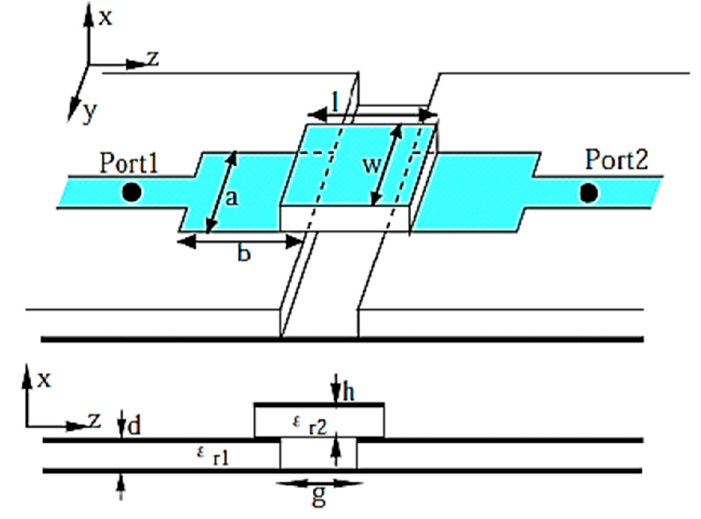
Figure 1. Ribbon wire interconnector.